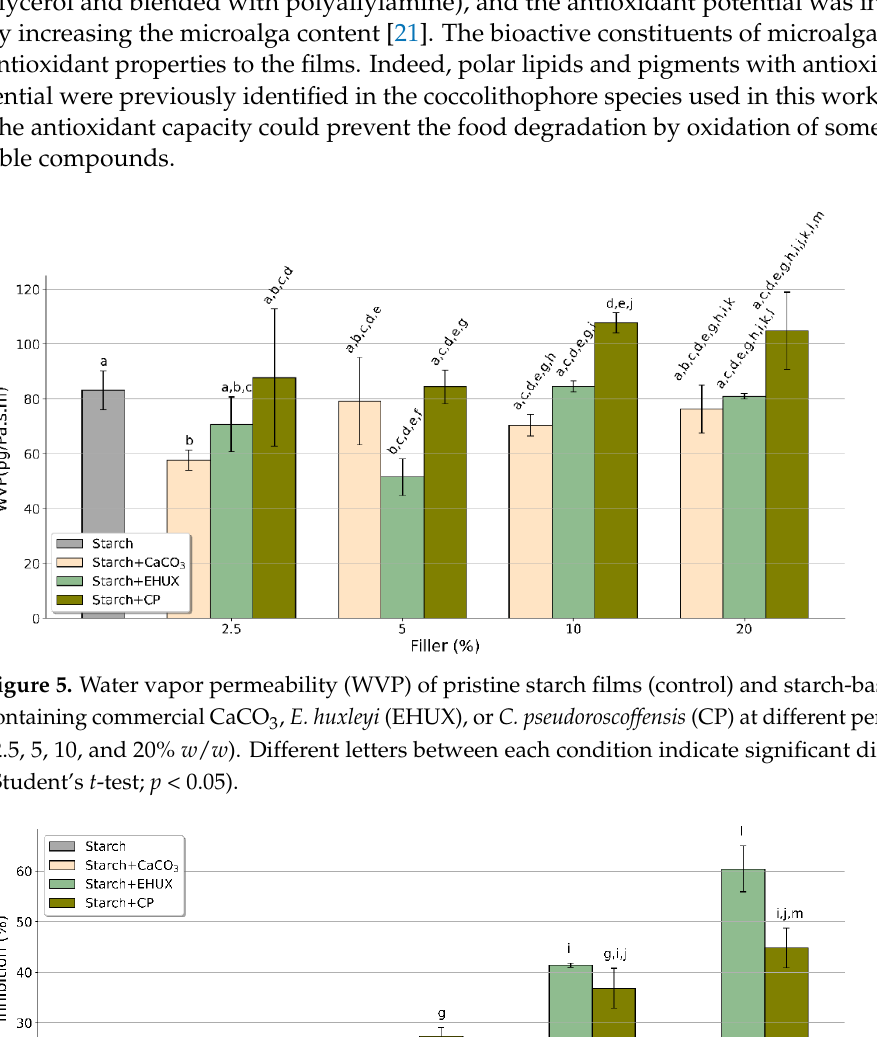
Figure 6. Percentage of ABTS • + inhibition after 5 h of incubation with starch films (control) and starch-based films containing commercial CaCO 3 , E. huxleyi (EHUX), or C. pseudoroscoffensis (CP) at different percentages (2.5, 5, 10, and 20% w / w ). Different letters between each condition indicate significant differences (Student’s t -test; p < 0.05).